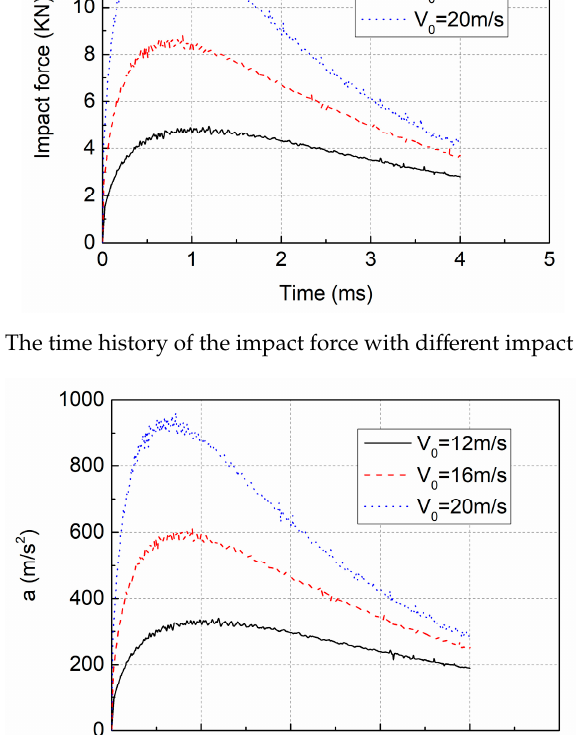
Figure 9. The time history of the acceleration with different impact velocities.